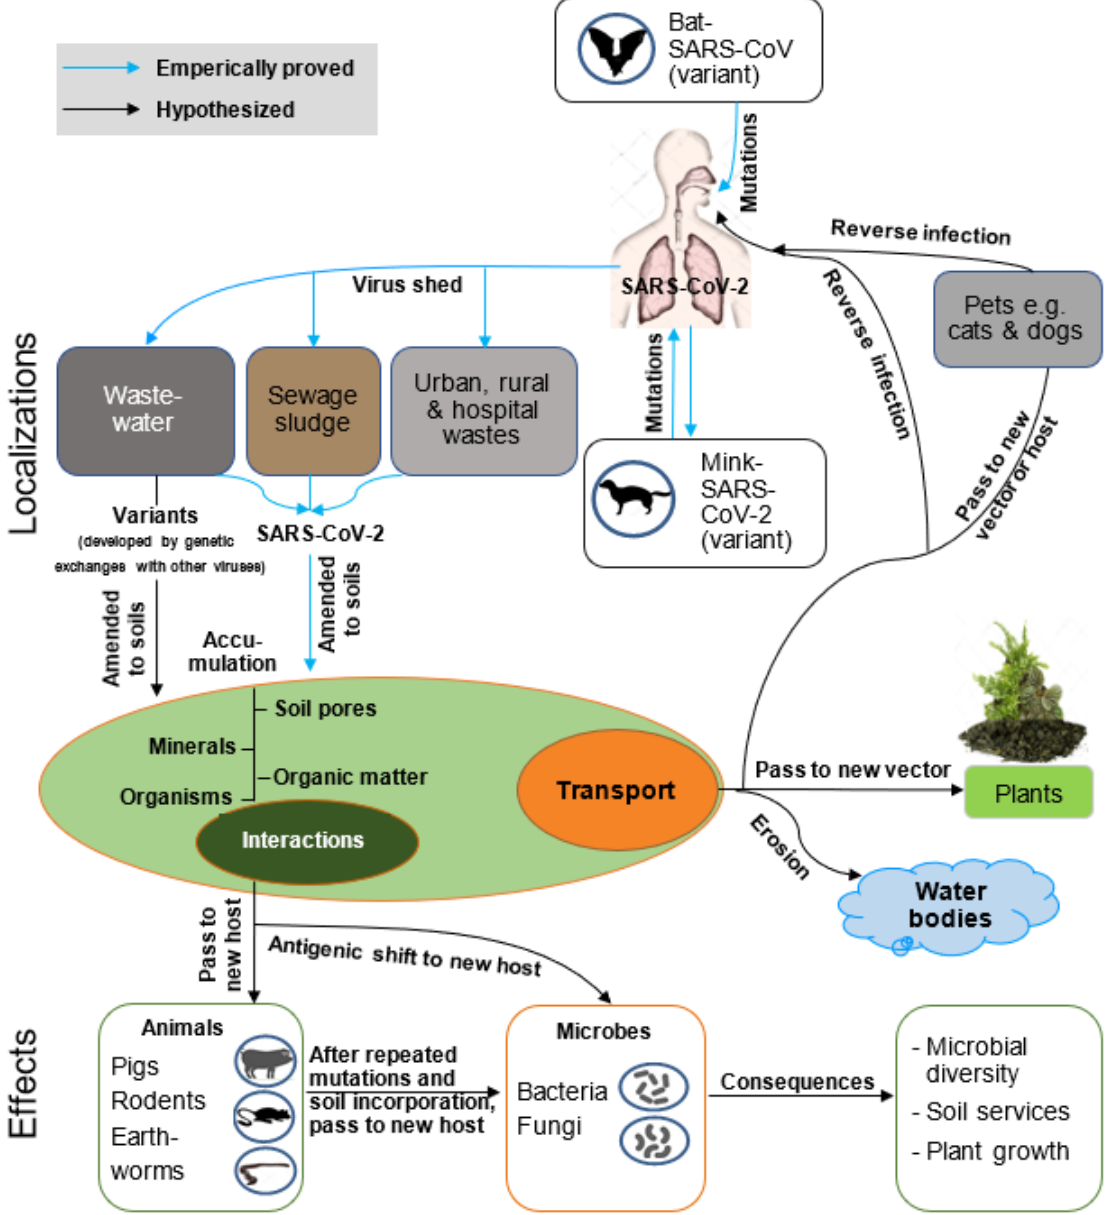
Figure 1. Conceptual model of SARS-CoV-2 entrance into soil, localization, and effects on soil life.